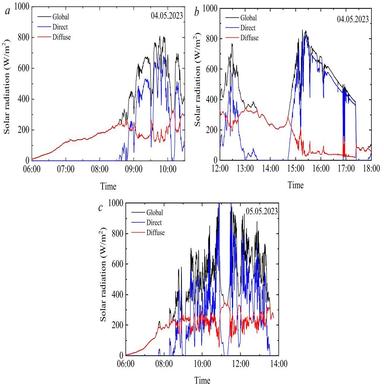
Diverse patterns of global Solar Irradiance, direct sunbeams, and diffused sunlight of 3D-SLA/MEPCM-40 samples.